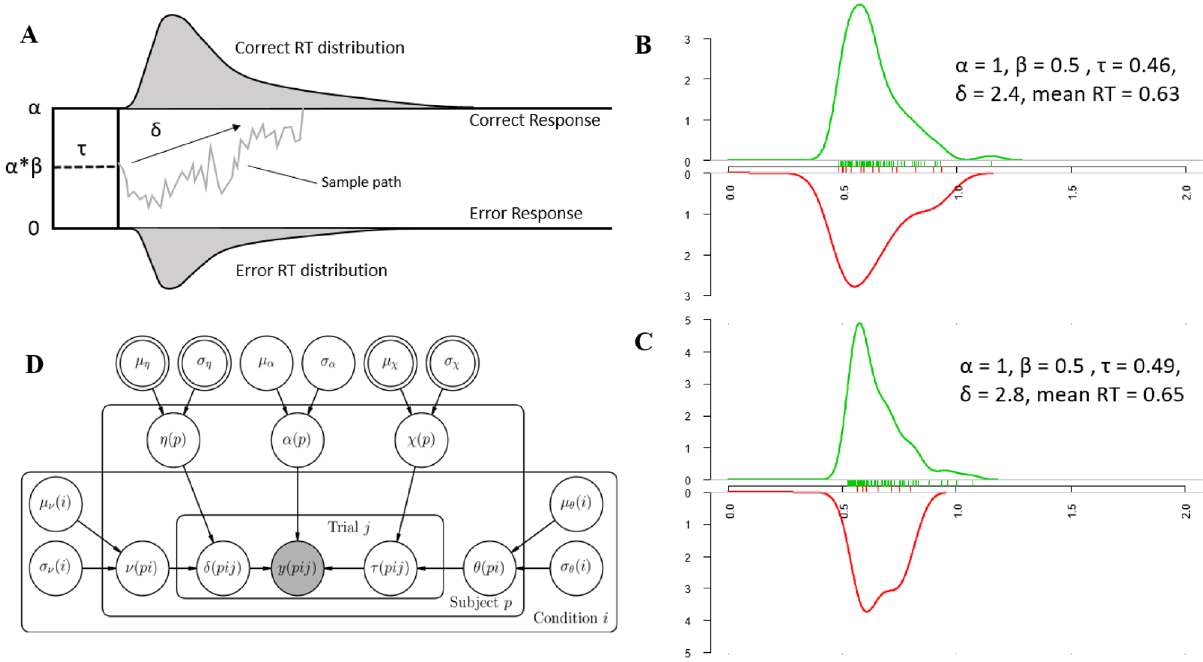
Figure 1. Graphical illustration representing the Wiener diffusion model and the hierarchical diffusion model (HDM). ( A ) A graphical illustration of the Wiener diffusion model. α = boundary separation indicating the evidence required to make a response; β = initial bias indicating the a priori status of the evidence counter as a proportion of α; δ = average rate of information uptake; τ = time used for everything except making a decision. The picture is drawn based on Vandekerckhove et al . 15 . ( B , C ) Plots showing generated reaction times (RT) via the ‘RWiener’ package 16 using the parameters shown in each figure. Although different parameters were used to generate the data, the mean reaction times are similar (two-sample t-test; t = 1.02, p = 0.31). ( D ) Graphical notation of the model used in parameter estimation. We followed the notation method suggested in the book ‘Bayesian Cognitive Modeling’ 17 . The node distinctions between observed versus unobserved variables use shaded and unshaded nodes, and those between stochastic versus deterministic variables use single- and double-bordered nodes. Subscripts and plates indicate repetitions of the parameter across participants p, conditions i, and trials